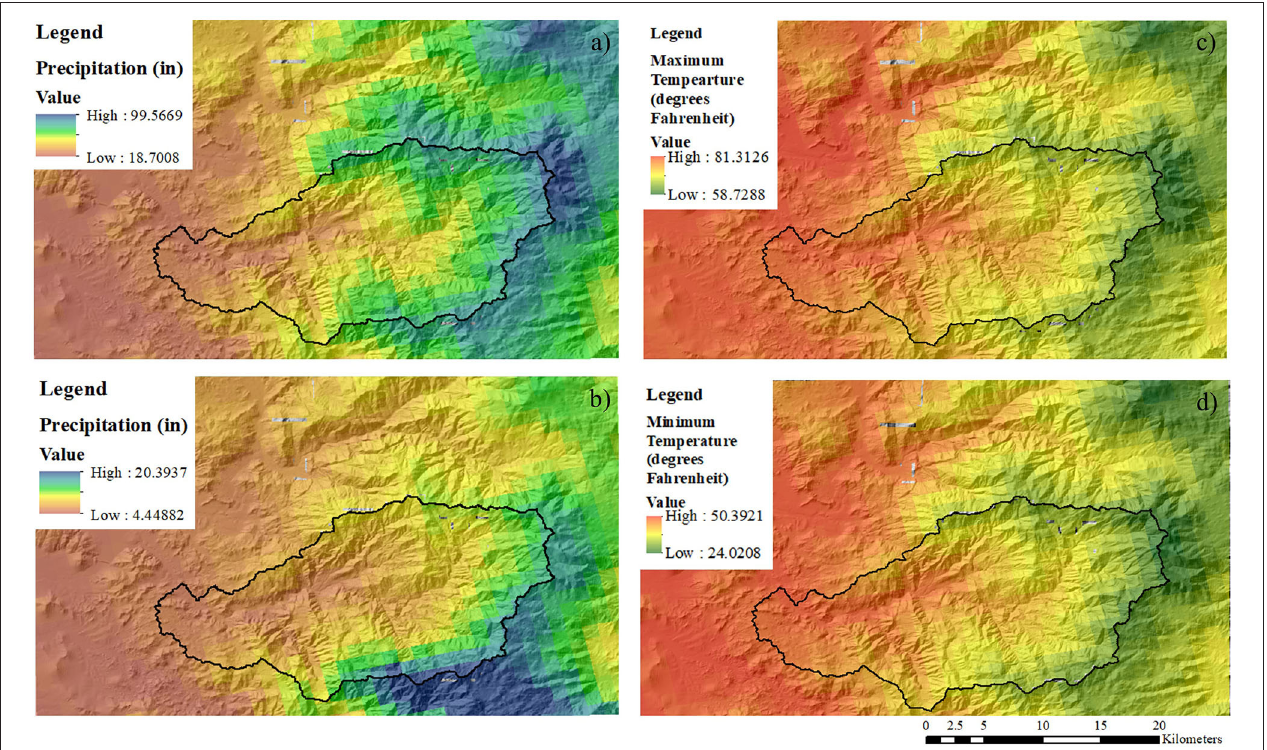
FIGURE 2 | (a) Average annual precipitation high in 1983; (b) average annual precipitation low in 2013; (c) average annual maximum temperature high in 2014; (d) average annual minimal temperature low in 1982. Calibration watershed outlined in